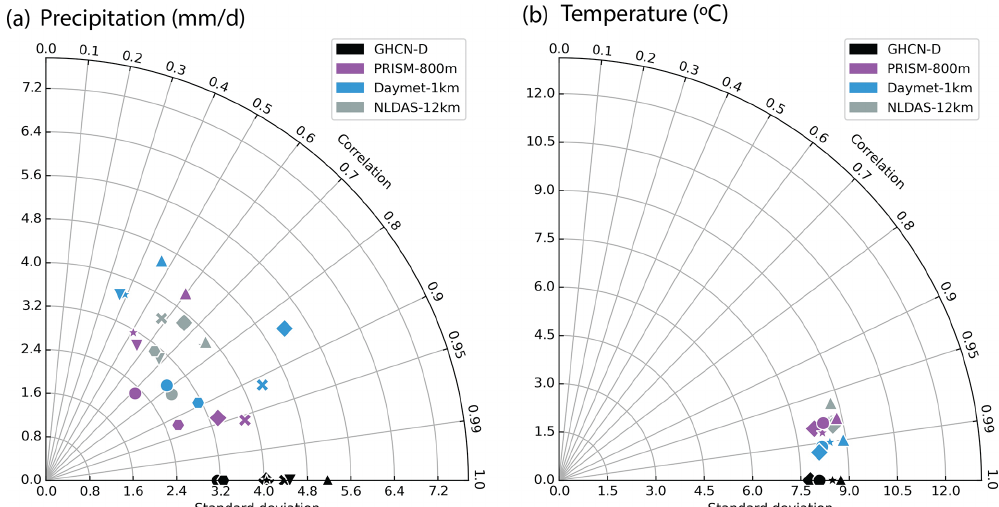
Figure 3. Taylor diagram showing the correlation coefficients and standard deviations between meteorological forcing and GHCN-D gages (black) for (a) precipitation and (b) temperature. The azimuthal angle represents correlation, and the radial distance represents the standard deviation. Each marker symbol represents a different GHCN-D station location.